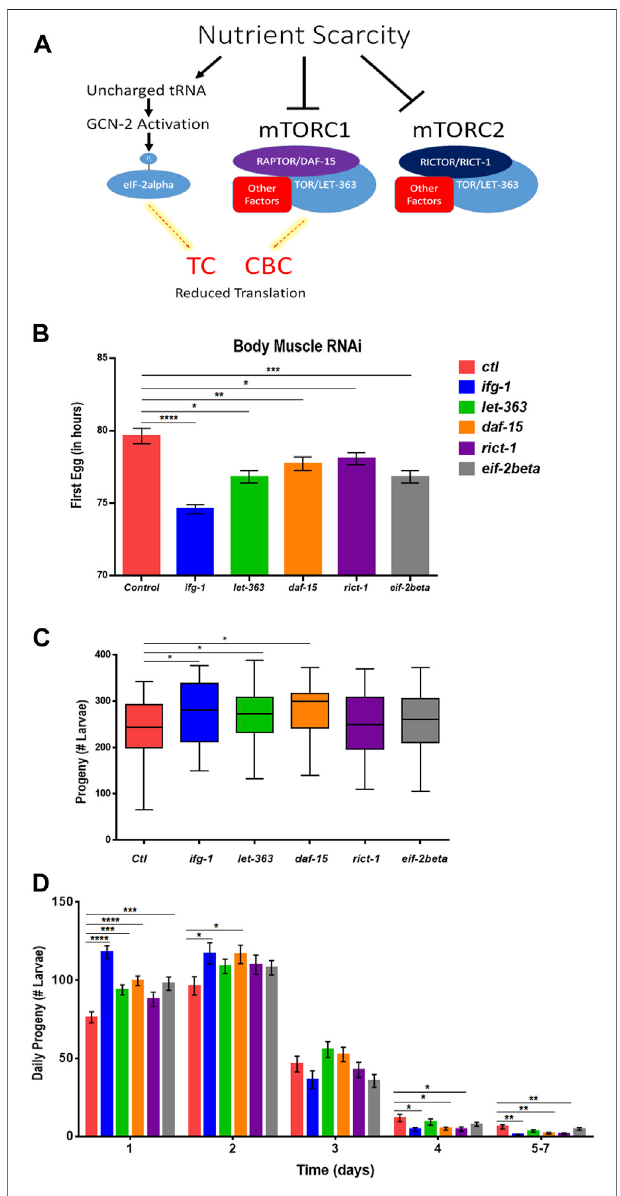
FIGURE 5 | Restricting mTORC1 or translation downstream of mTORC1 selectively in body muscle increases fecundity. (A) Schematic showing the two major arms of translation initiation in fl uence by nutrient limitation. The CBC is driven by signals from mTORC1, while the TC is independent of mTOR. Thin dashed red lines highlighted in yellow indicate reduced activity. (B – D) Larvae for the WM118 body muscle-speci fi c RNAi strain were raised on bacteria expressing dsRNA for genes targeting subunits of mTORC1, mTORC2, and the TC. The average time to reproductive adulthood is shown in (B) , whereas (C) shows the average number of viable progeny and (D) shows the average daily number of progeny for each condition. Error bars in (B) and (D) represent the standard error of the mean. Signi fi canceinbargraphs (B,D) andTukeyboxplots (C) wascalculatedusing unpaired t-test with Welch ’ s Correction (* p < 0.05, ** p < 0.01, *** p < 0.001, **** p < 0.0001). Data were pooled from three experiments ( Supplementary Tables S7, S8